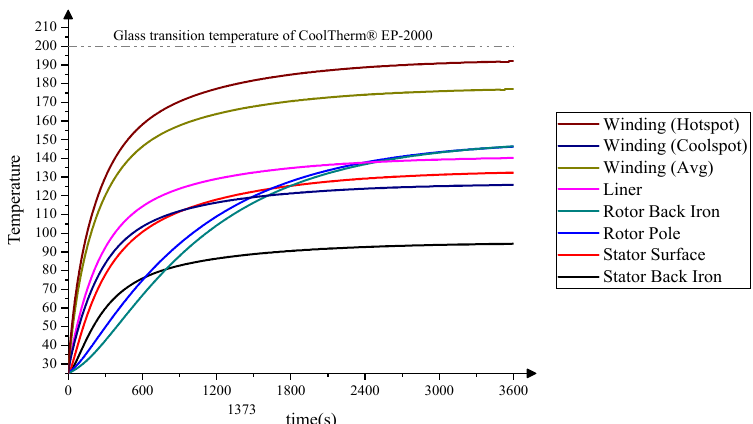
Figure 27. Transient thermal performance of the LSA SRM calculated in MotorCAD.